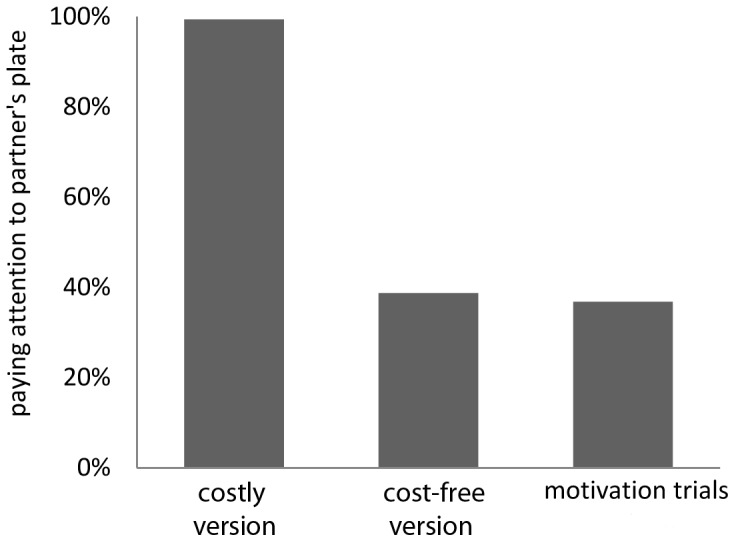
Attention of donors to the partner’s plate before pulling.Percentage of trials when donors looked at the partner’s plate in test sessions of the costly version (reward on partner’s side), the cost-free version (reward on both sides) and during motivation trials (one reward on donor’s side). The presence of a reward for the partner in addition to a reward to the subject herself does not increase attention to the partner’s plate.